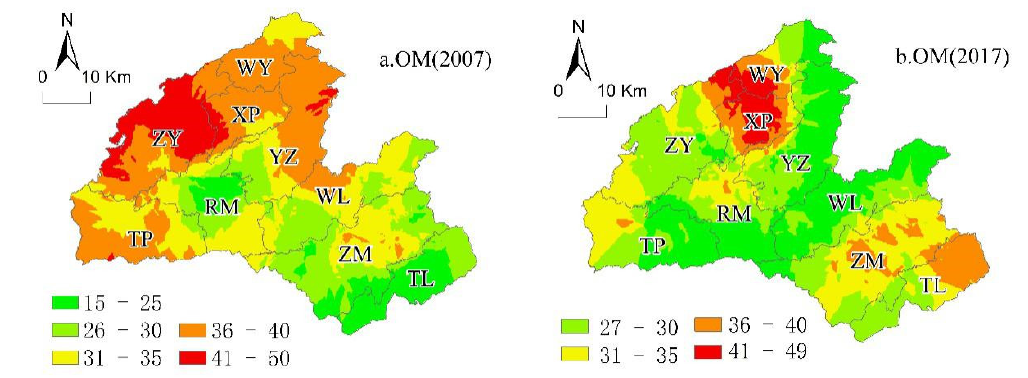
Figure 5. Ordinary kriging distribution maps for ( a ) 2007 OM and ( b ) 2017 OM.